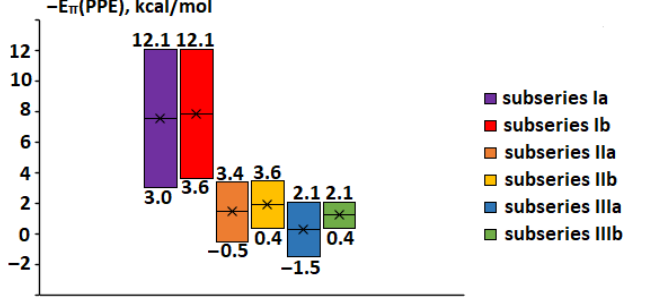
Figure 6. Ranges of changes for the − E π (PPE) values: subseries Ia,b ; IIa,b , and IIIa,b —double bond, para-phenyl ring, and meta-phenyl ring, respectively, as the π -bridge. The R 1 substituent is fixed and the R 2 substituent varies in part a of the subseries, the R 2 substituent is fixed and the R 1 substituent varies in part b of the subseries.